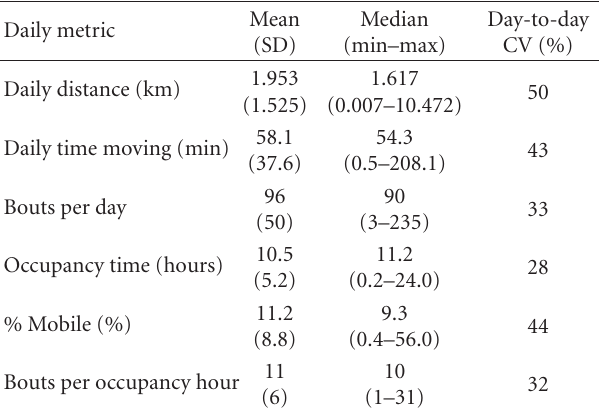
Table 4: Daily wheelchair